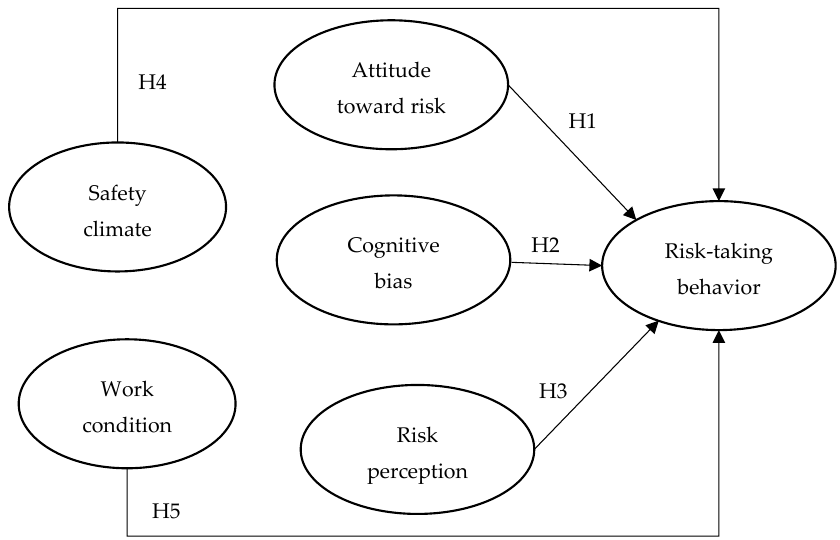
Figure 1. Proposed research model for explaining construction worker risk-taking behaviour to be tested in this study.